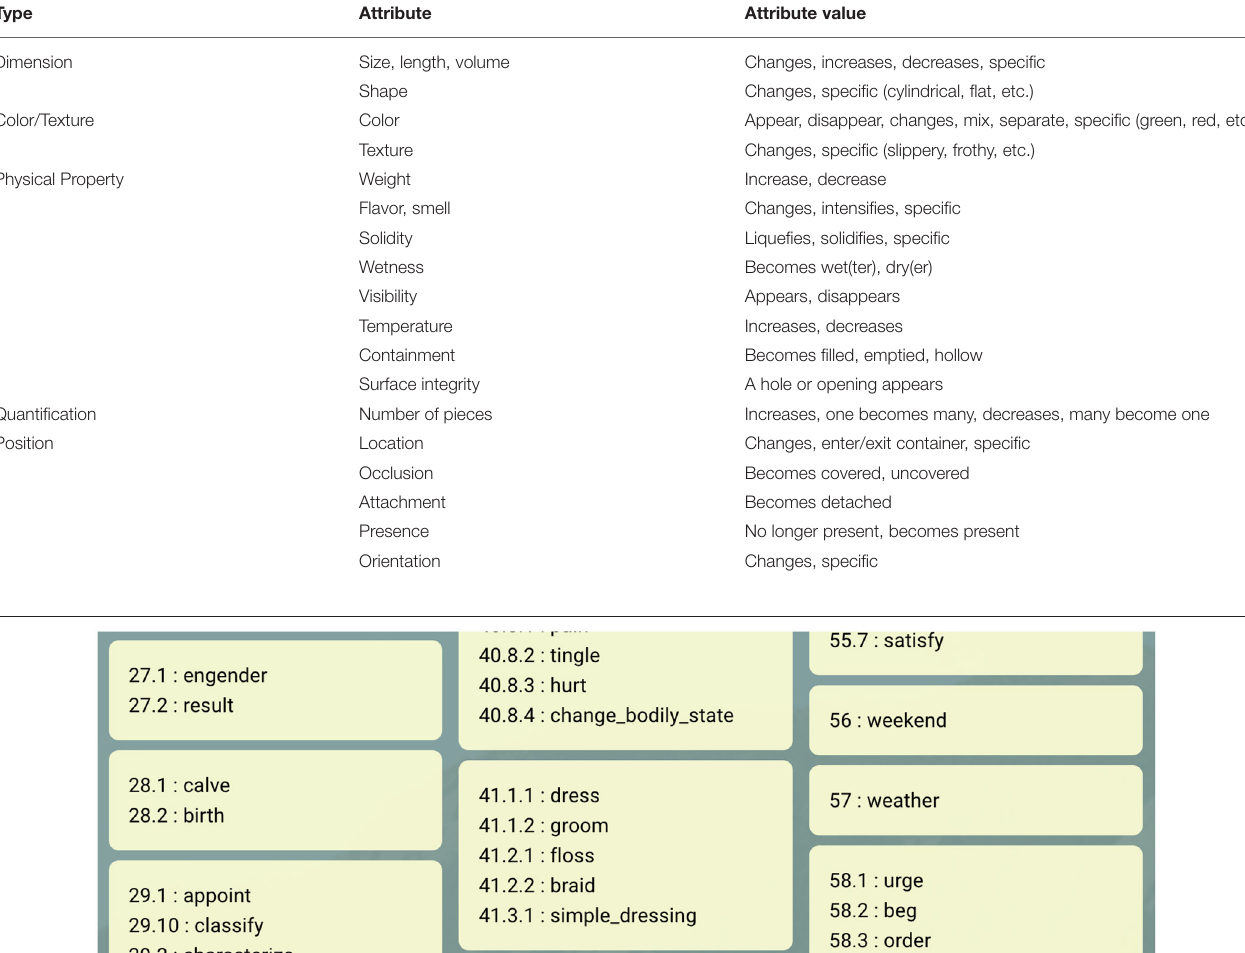
TABLE 1 | Categories of physical causality (Gao et al., 2016).